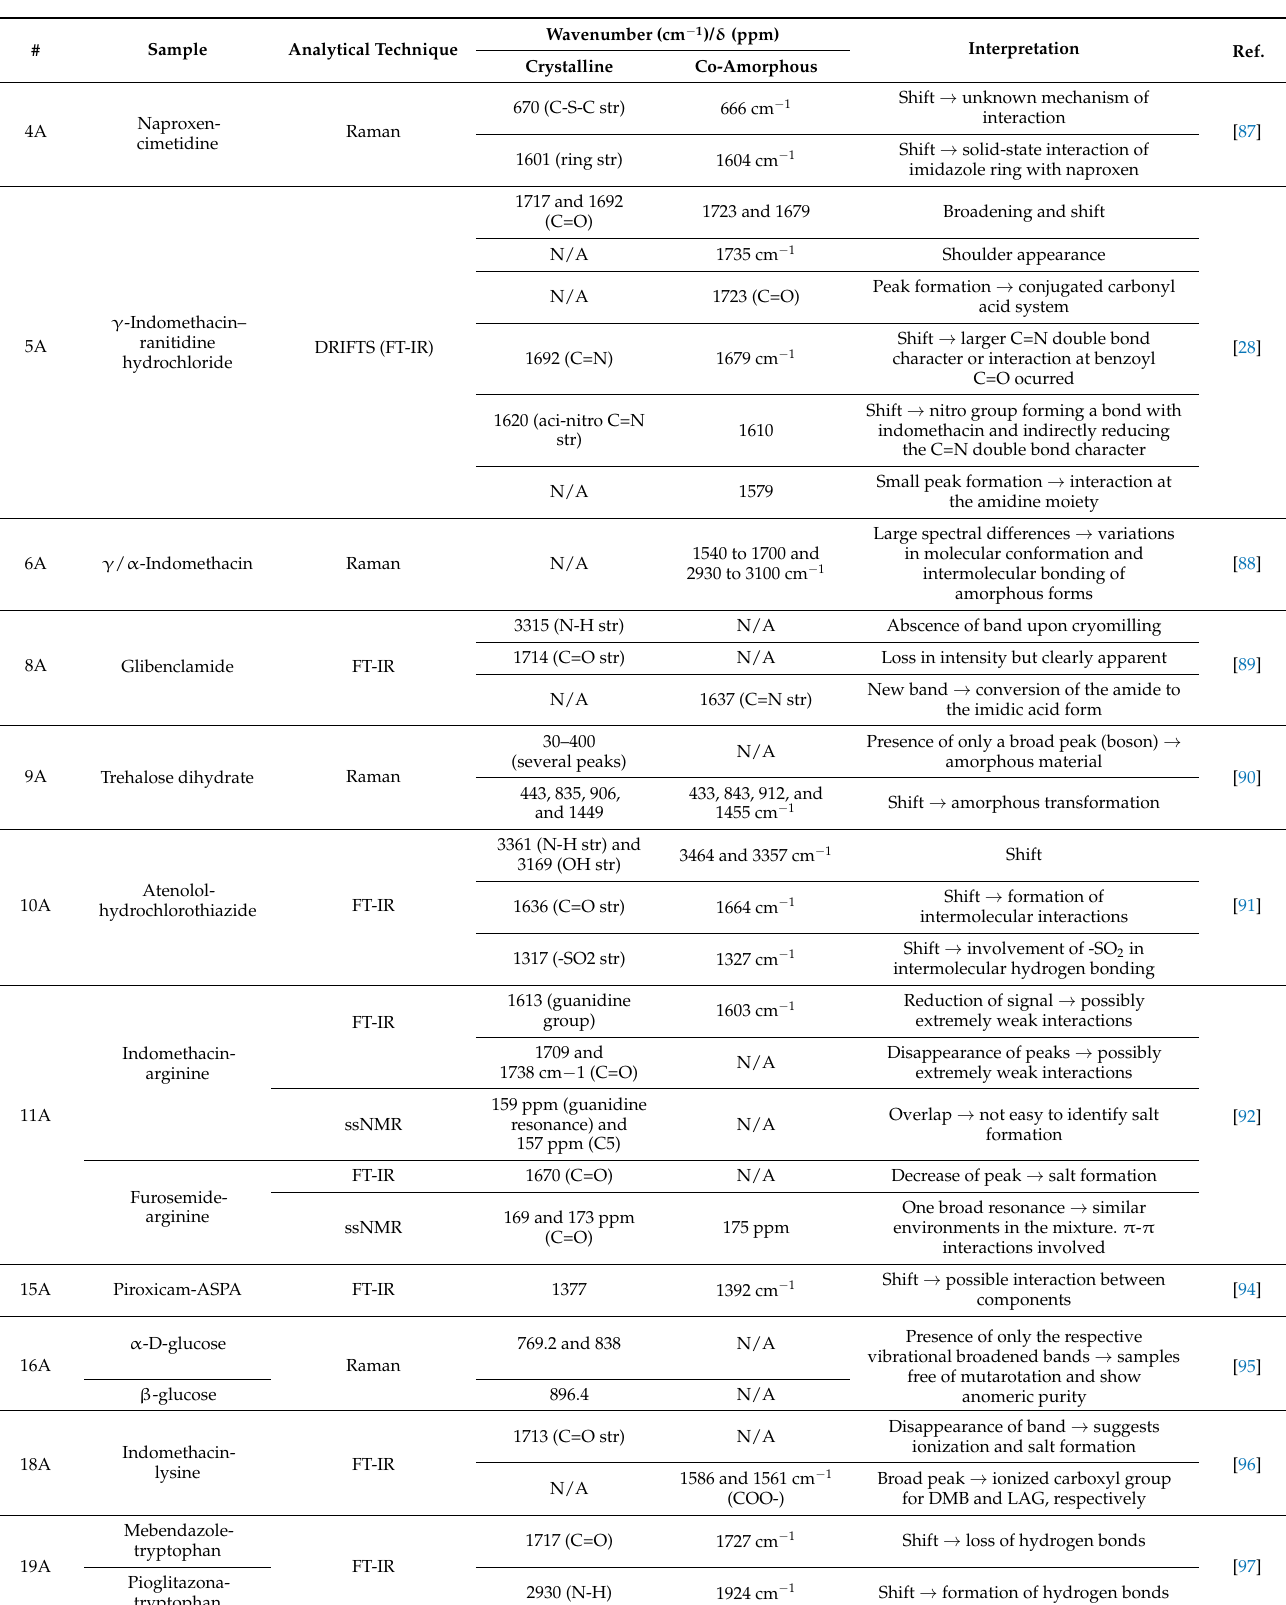
Table 6. Overview of structural characterization by spectroscopy of amorphous/co-amorphous drugs obtained by